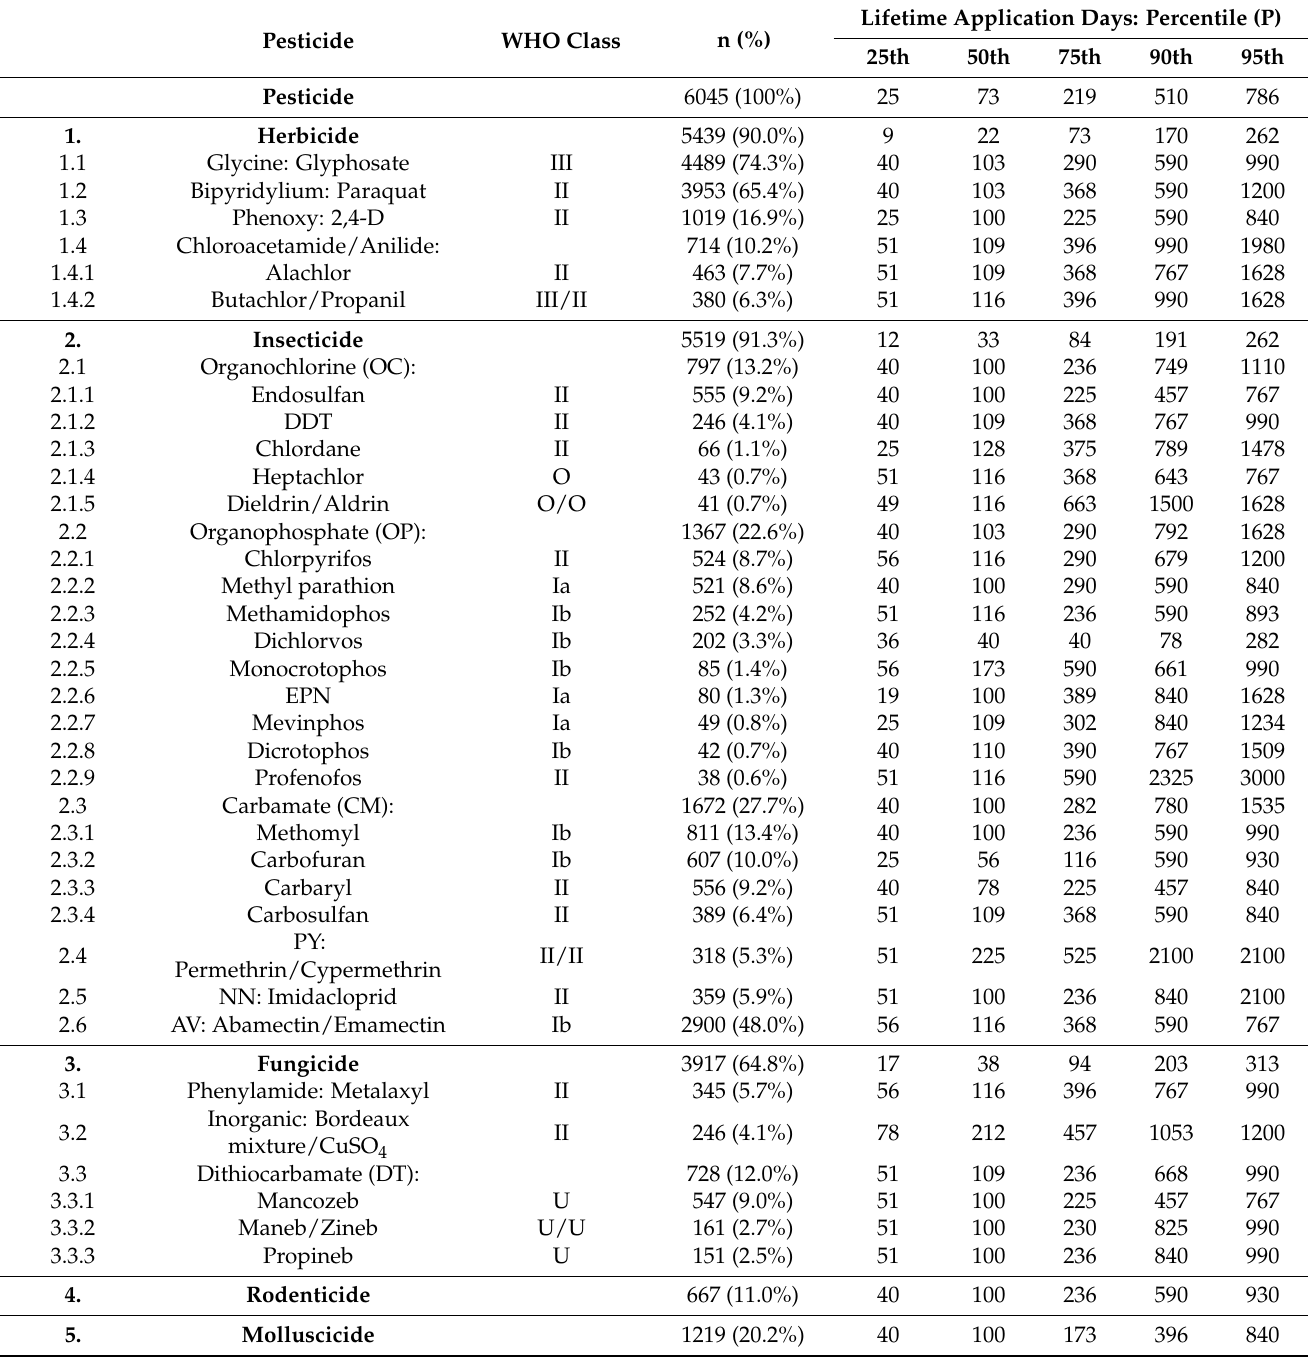
Table 2. History of individual pesticide use among Thai famers (n =